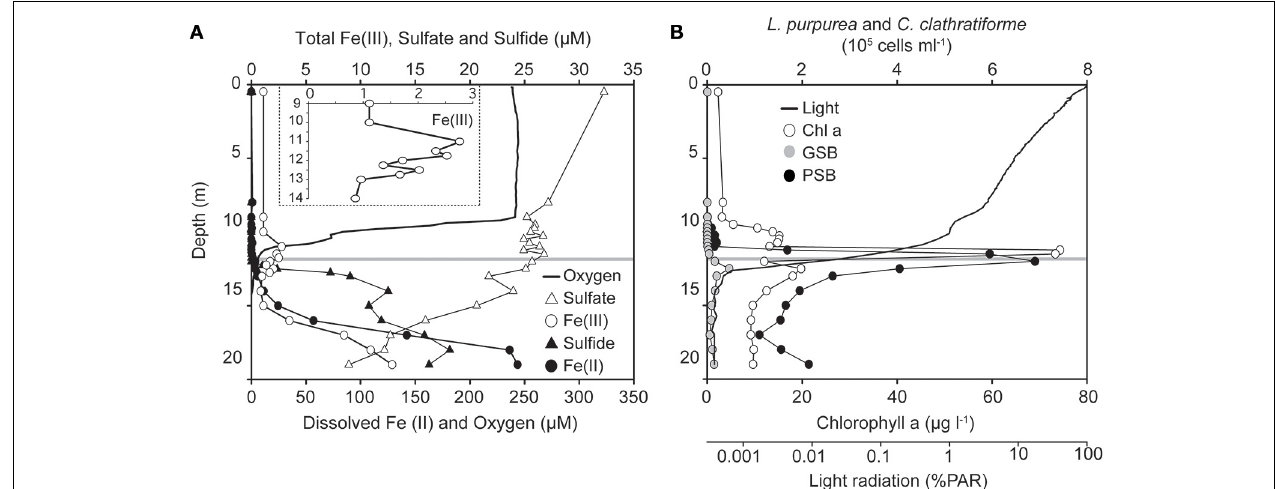
FIGURE 1 | Summer stratification water column data of Lake La Cruz. (A) Chemical stratification at the time when incubation experiments were performed (13/Oct/2008). The insert depicts a magnified Fe(III) concentration profile around the chemocline. (B) Vertical distribution of oxygenic (chlorophyll a concentration, open circles) and anoxygenic phototrophs. Black symbols